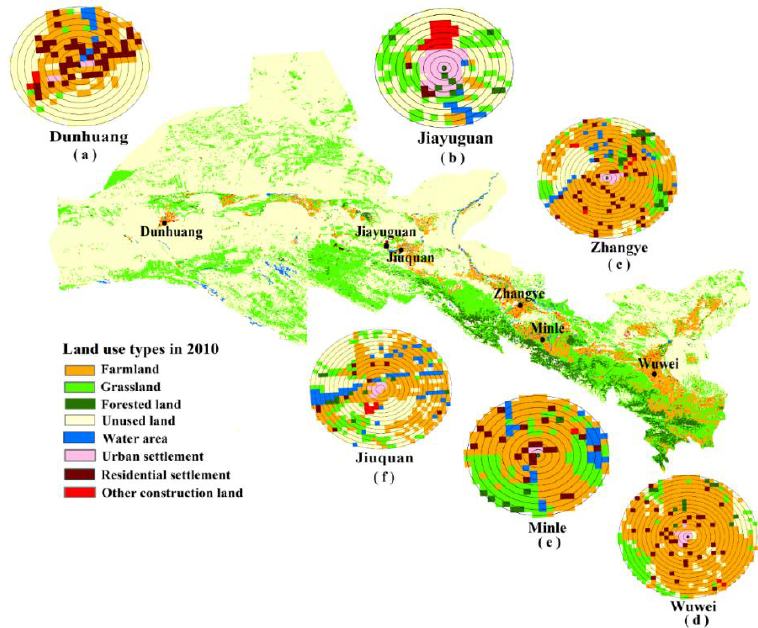
Figure 3. Spatial patterns of land use types of the Hexi Corridor and the selected cities and counties ( a – f ).